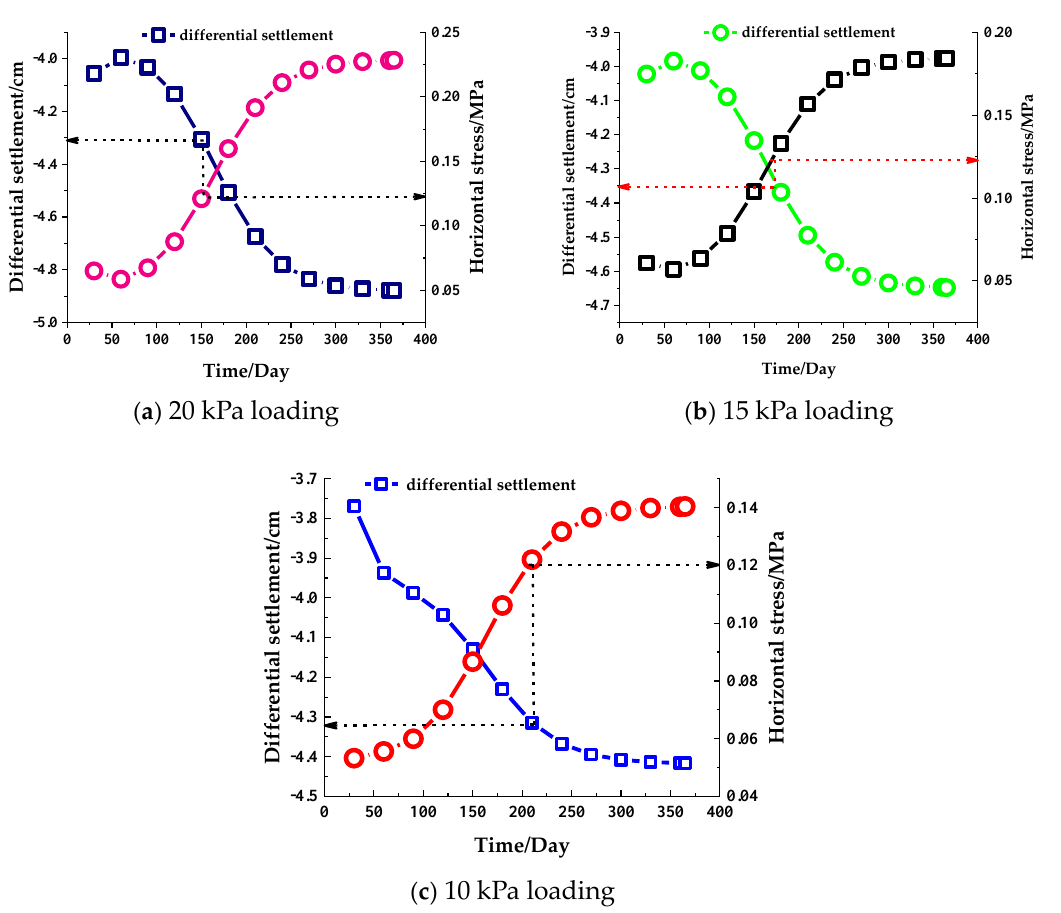
Figure 14. Horizontal stress of pavement and differential settlement of HTL.